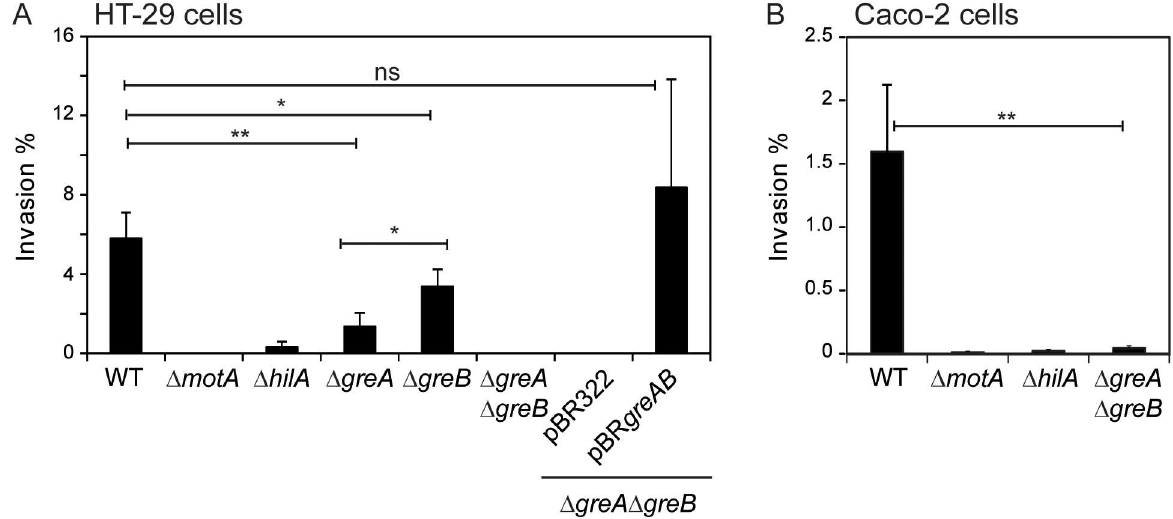
Fig 1. Invasion of epithelial cells by S . Typhimurium is impaired in strains deficient for the Gre factors. Cultures of the WT (SV5015) and the Δ greA , Δ greB and Δ greA Δ greB derivatives were assessedfor invasionof HT-29 (A) and Caco-2 (B) cell lines. As a control, cultures of the invasionimpairedmutants Δ hilA and Δ motA were used. A bar shows the arithmetic mean of experimental results and the error bar indicatesthe standarddeviation. Significancewas tested by an unpairedtwo–sidedStudent’s t-test. Statistical